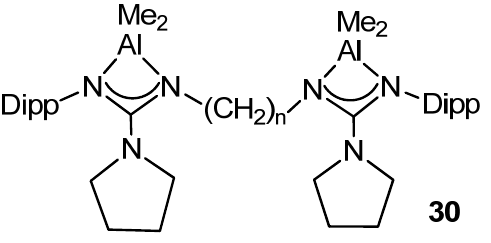
Figure 22. Dinuclear aluminum compounds, catalyst for ring-opening polymerization ( n = 2, 3, 4). The protonolysis of AlMe 3 with trisubstituted arylguanidines allows to prepare mono-